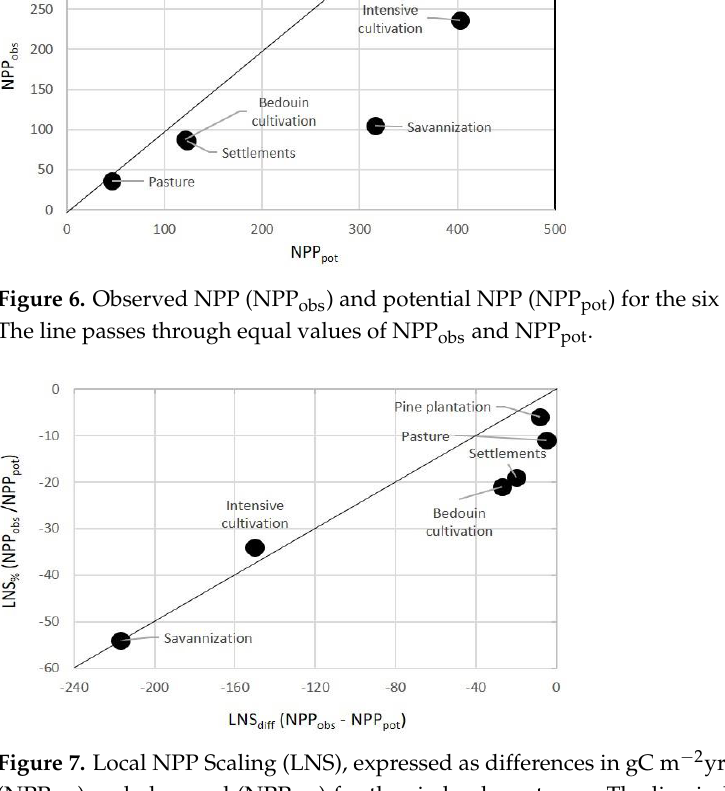
Figure 7. Local NPP Scaling (LNS), expressed as differences in gC m −2 yr −1 and ratios of potential (NPP pot ) and observed (NPP obs ) for the six land use types. The line indicates a constant ratio of LNS diff /LNS % .